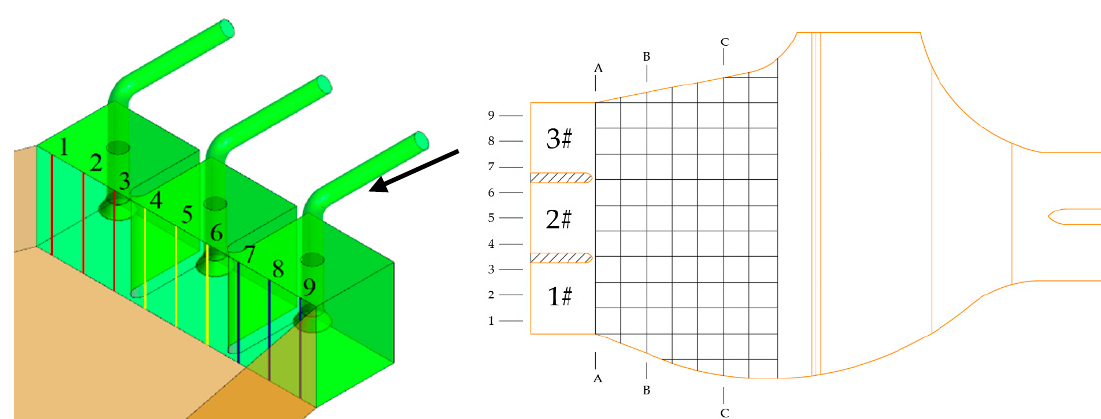
Figure 6. The layout of the section and line velocity measurements.